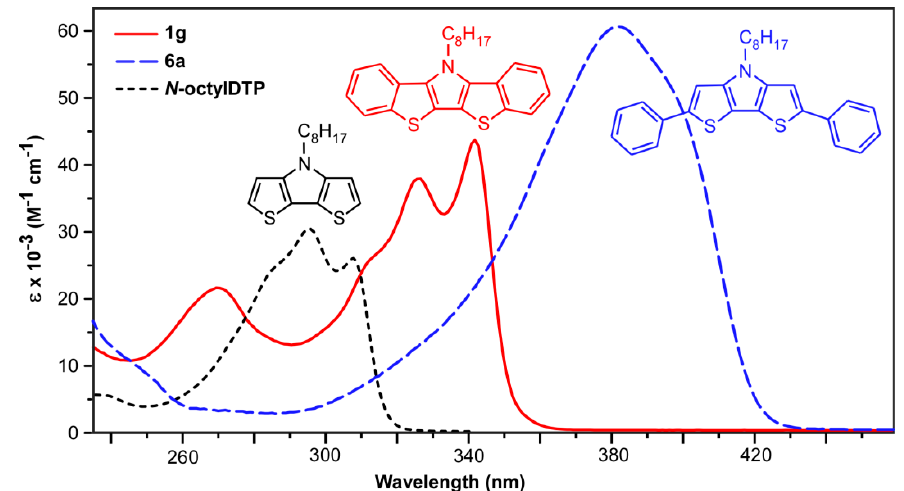
Figure 6. UV ‐ visible spectra of N ‐ octylbis[1]benzothieno[3,2 ‐ b :2 ′ ,3 ′‐ d ]pyrrole ( 1g ), N ‐ octyl ‐ 2,6 ‐ diphenyldithieno[3,2 ‐ b :2 ′ ,3 ′‐ d ]pyrrole ( 6a ), and N ‐ octyldithieno[3,2 ‐ b :2 ′ ,3 ′‐ d ]pyrrole in CH 3 CN.